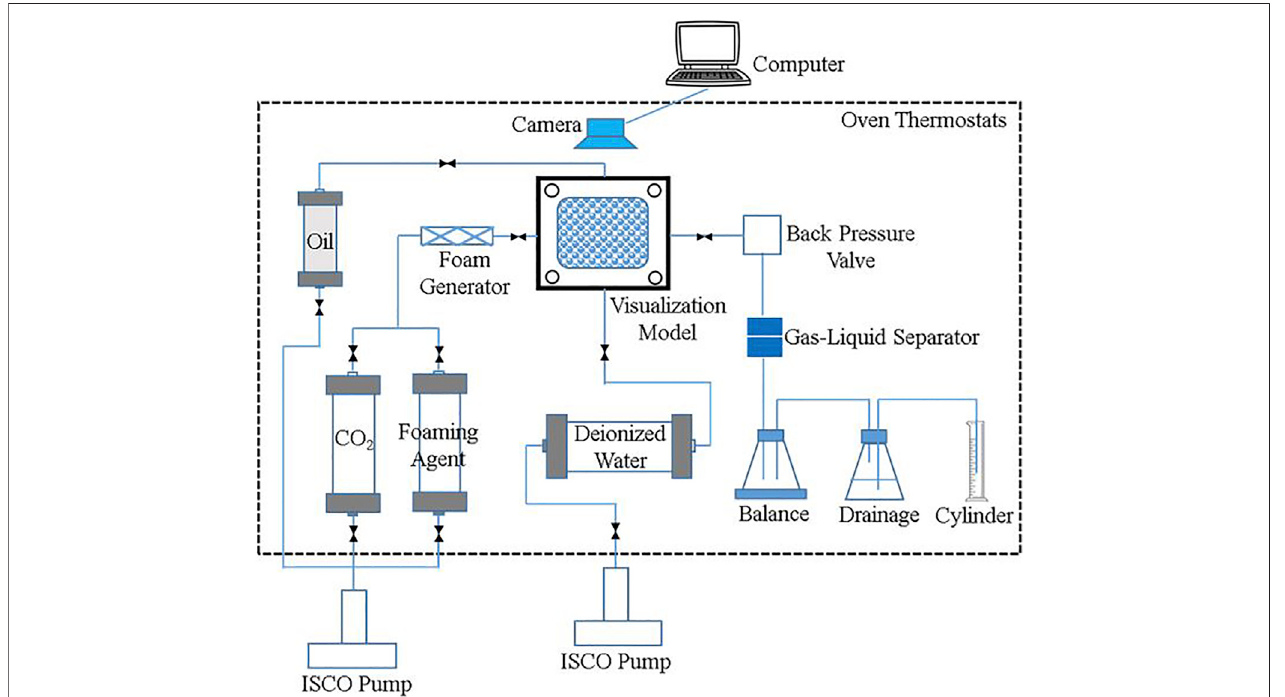
FIGURE 3 | Schematic of the experimental setup for visual oil displacement